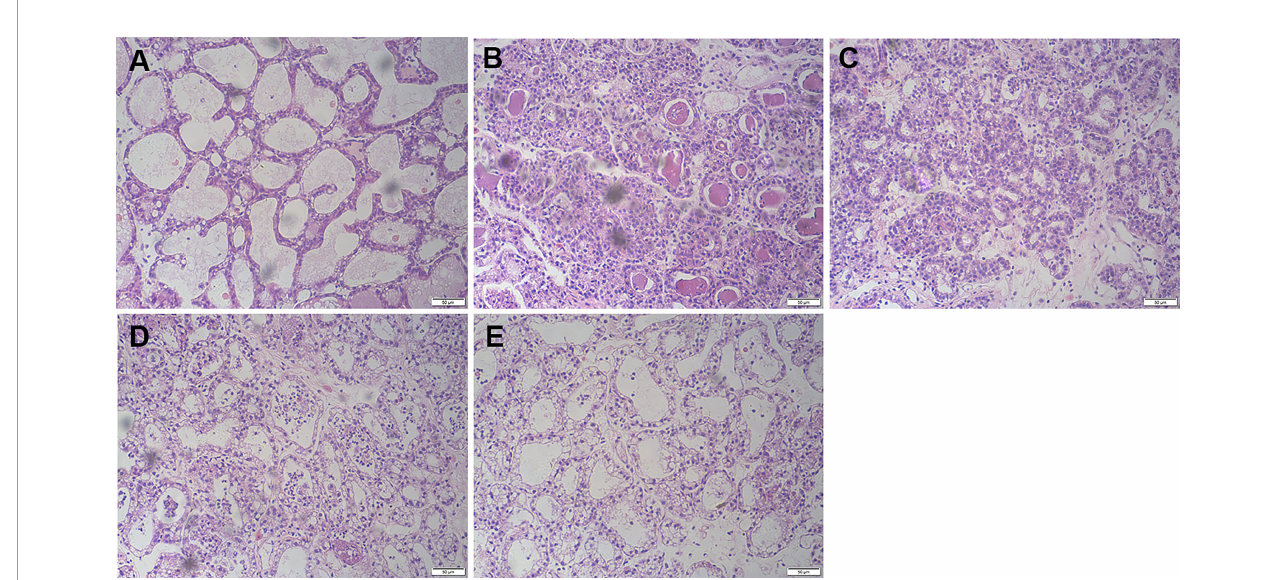
FIGURE 1 | Effects of FOR on LPS-induced histopathological changes in mice with mammary (magni fi cation 200×). (A) Control group: normal mammary gland tissue structure. (B) LPS group: severe in fl ammatory cell in fi ltration. (C – E) LPS + FOR (10, 20, 30 mg/kg) groups: gradually decreasing in fl ammatory cell in fi ltration after administration of